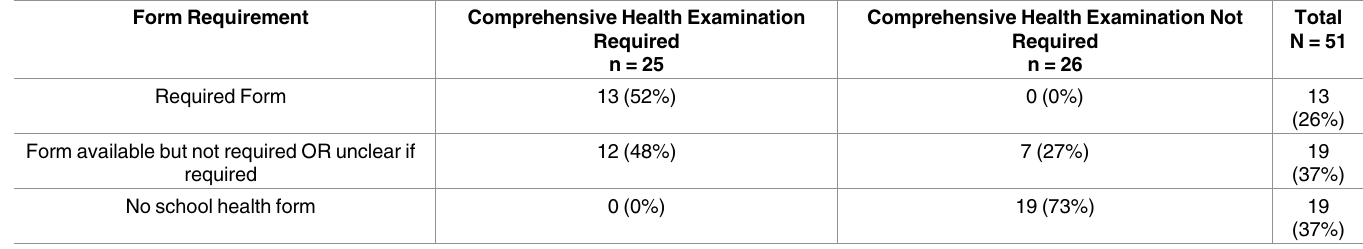
Table 1. Student health screening form requirements for states with and without required comprehensive school health examinations. Form